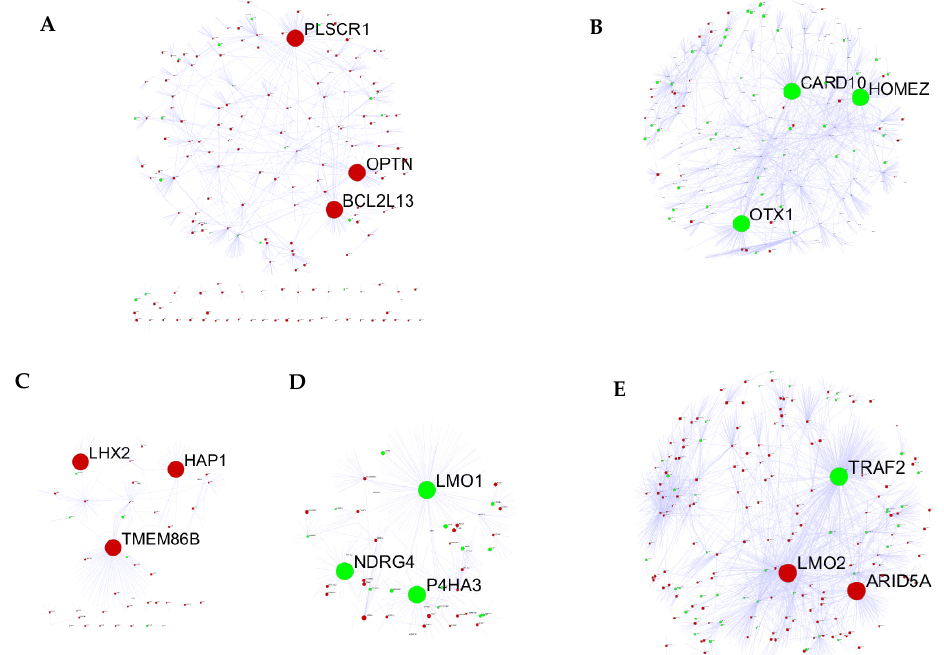
Figure 5. The PPI networks of IAV-related modules. The clearly labeled node was the top hub gene. The red: positive coefficient; the green: negative coefficient. ( A ) Salmon module; ( B ) Greenyellow module; ( C ) Orange module; ( D ) Skyblue module; ( E ) Purple module.